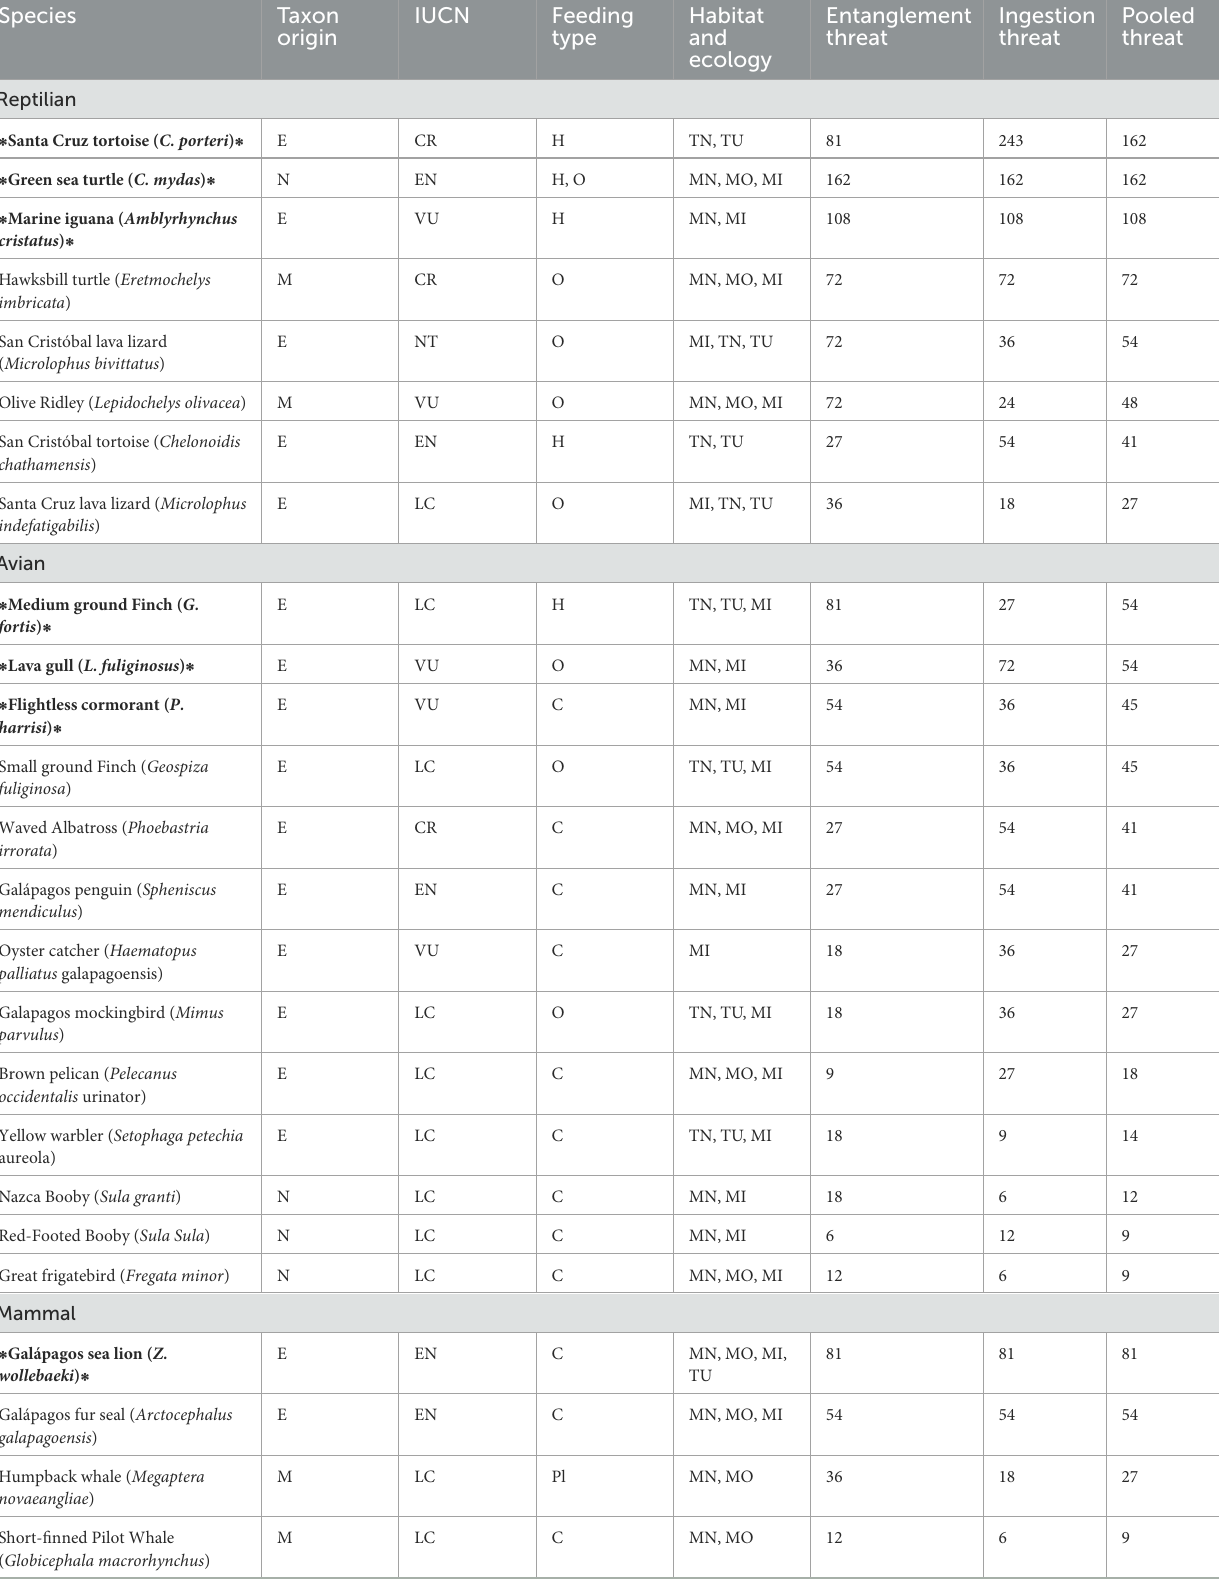
TABLE 4 The 52 species recorded interactions with plastic pollution (PP) in the Galápagos Islands (entanglement or ingestion) and the threat scale in Galápagos for the reported species. Species Taxon